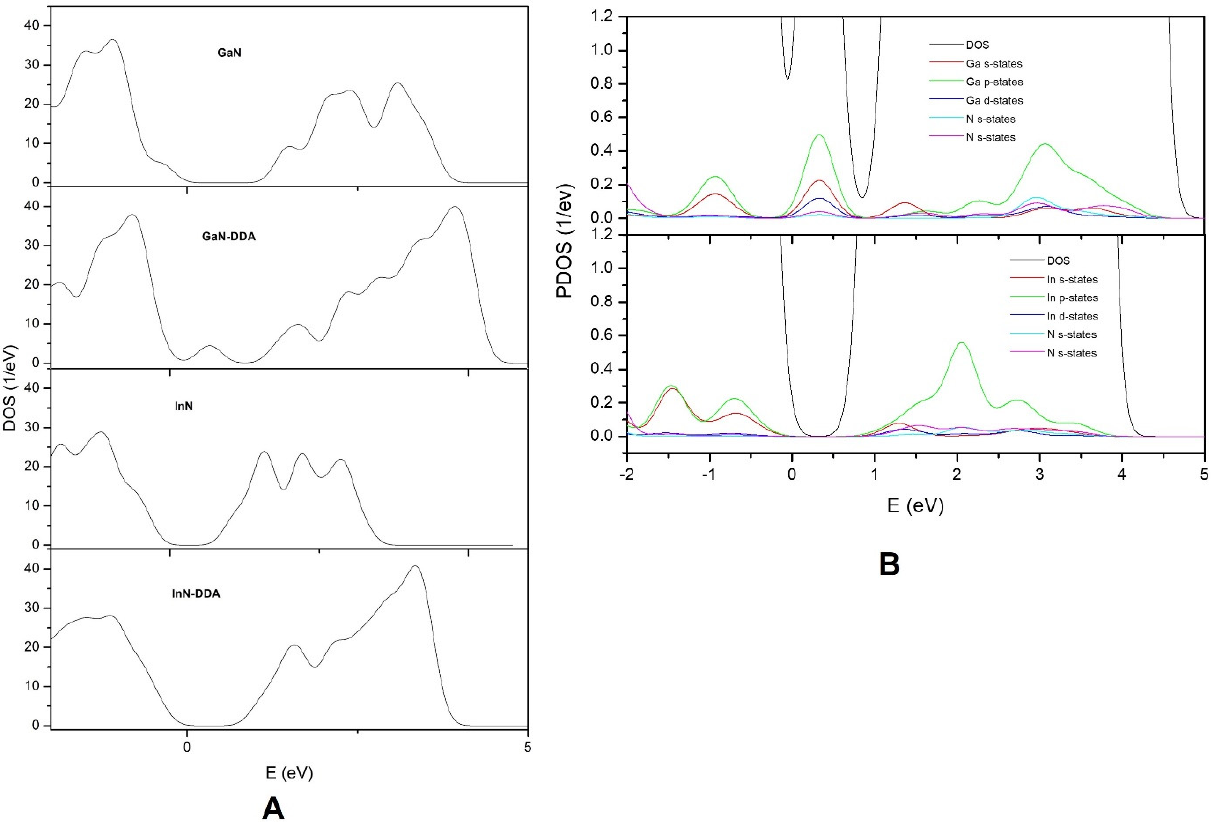
Figure 6. DOS of the structure for GaN and InN with and without DDA at position 1 ( A ). PDOS for the projected states of N, Ga and In atoms at position 1 for GaN-DDA and InN-DDA, respectively ( B ). The Fermi level is set to 0.